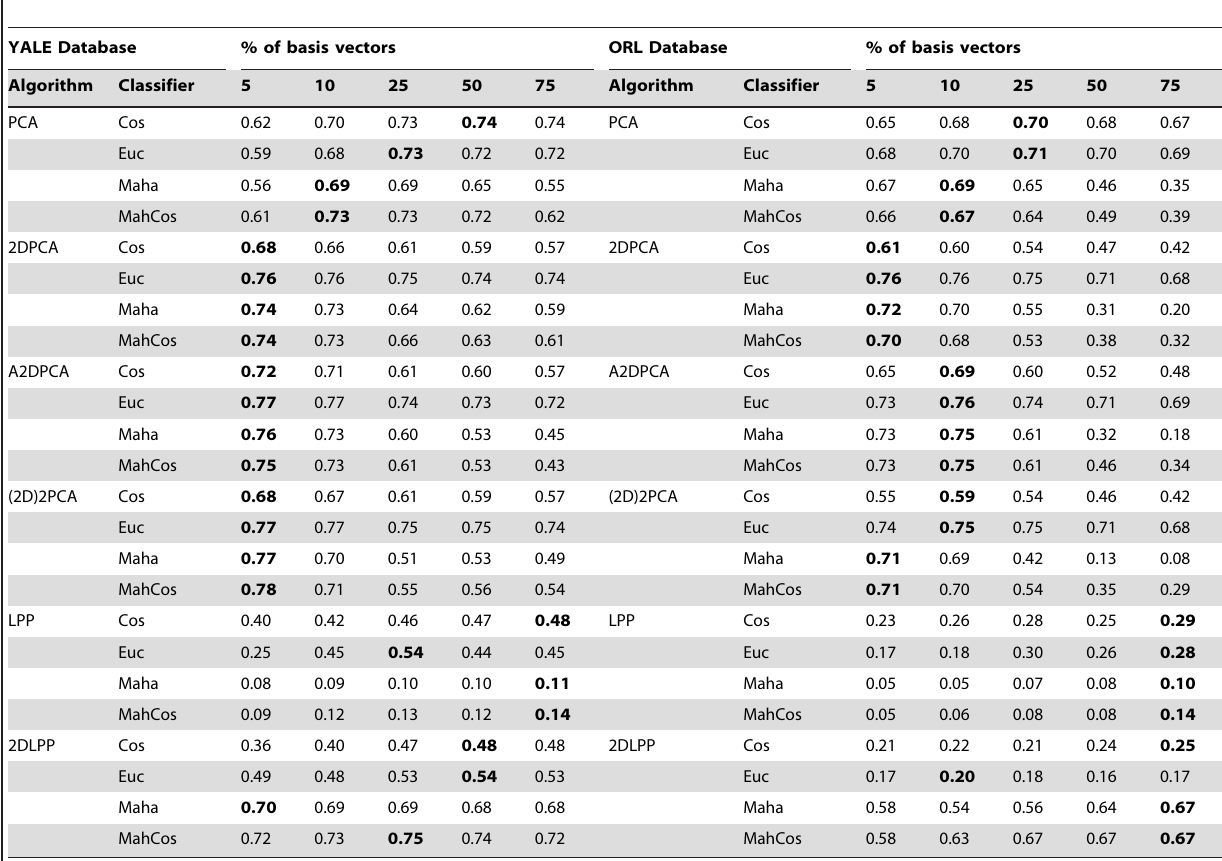
Table 5. Average Recognition Rate over 50 ranks for YALE database and ORL database.